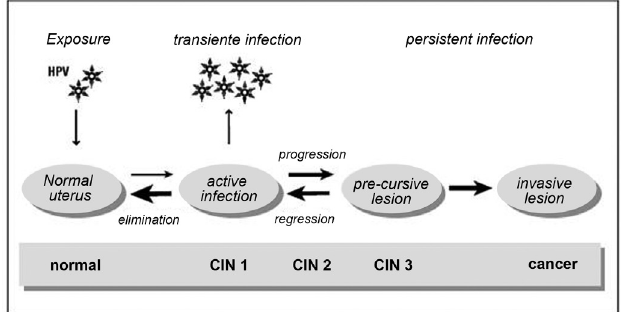
FIGURE 1 - Natural history of cervical cancer. CIN: cervical intraepithelial neoplasia. Adapted from: Cervix cancer screening. Lyon, IARC Press, 2005 (IARC Handbooks of Cancer Prevention, Vol